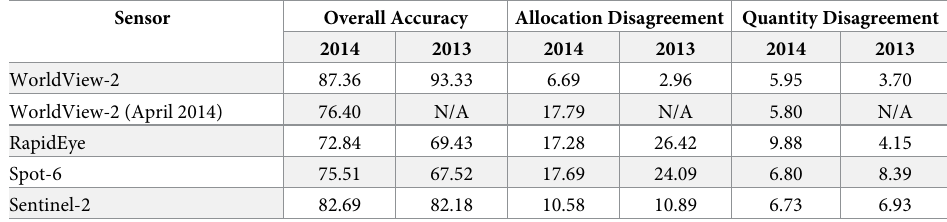
Table 8. Classification accuracy of different flowering vegetation communities in the Mwingi study site during the start of the flowering season (January 2014) and the peak of the flowering season (February 2013) using resam- pled simulated